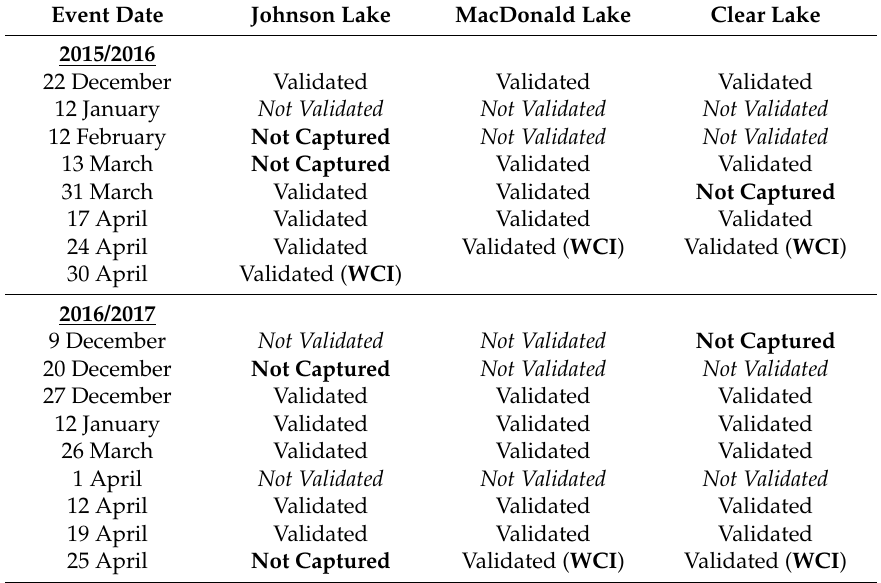
Table 3. Summary of the validation of major melt/WCI events for the 2015/2016 and 2016/2017 ice seasons. “Validated” events were melted or WCI events confirmed by shoreline observations and climate data. “Not Validated” events were melted events identified by the threshold method but did not match observations in shoreline cameras or local climate data and “Not Captured” events indicate that no melt or WCI event was reported for that lake on the specific